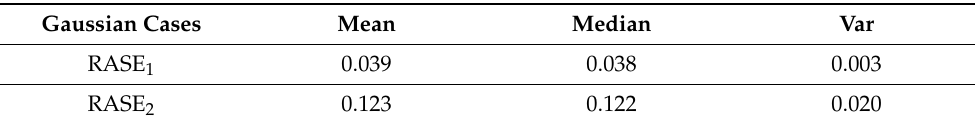
Table 13. The RASE criterion with the non-parametric function η ( . ) and slope function β ( . ) for the case n = 500.